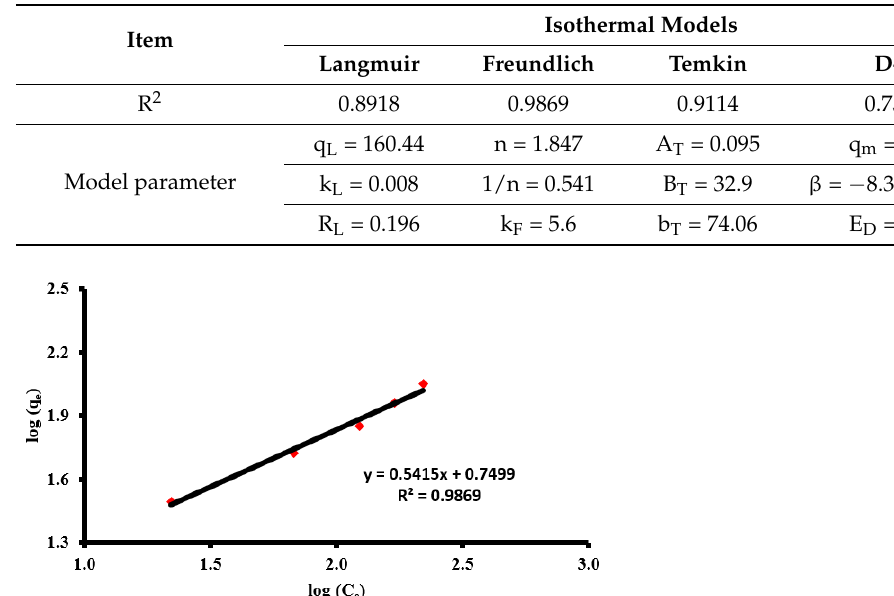
Table 3. Isotherm models of the adsorption of AZM onto the ZnONPs.